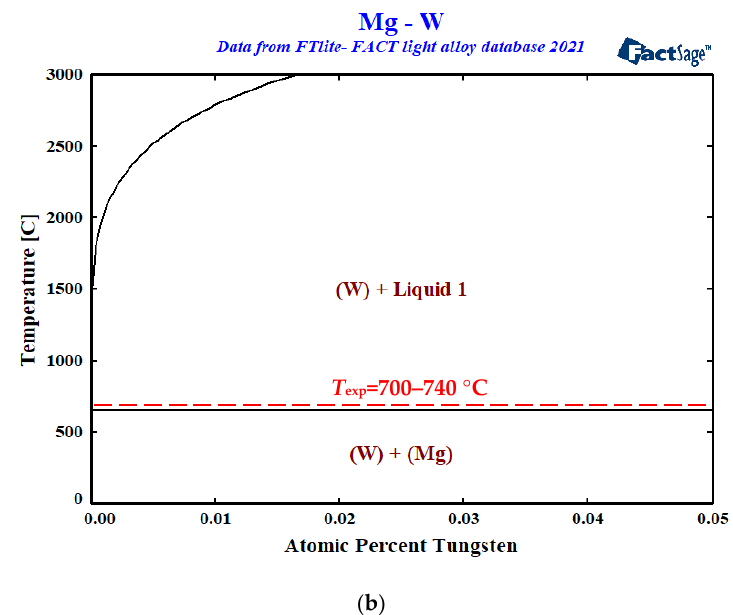
Figure 10. Phase diagram of the Mg – W system calculated in this study with the use of FactSage software and FTlite database [23]; the insert in ( a ) corresponds to the magnified Mg-rich region shown in ( b ).